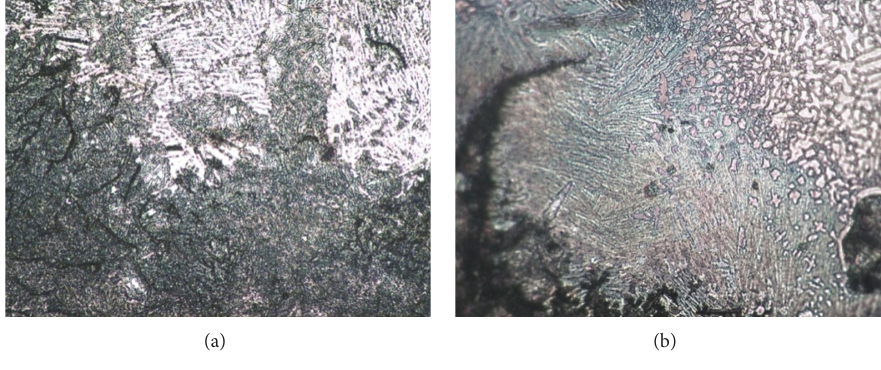
Figure 5: Morphologies of BZ × 200: (a) Fe314, (b)